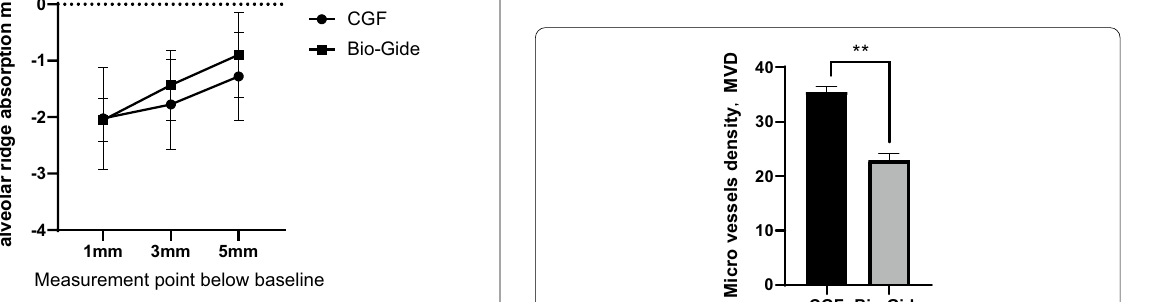
Fig. 8 Changes of alveolar ridge width 6 months after ARP in CGF group and Bio-Gide group